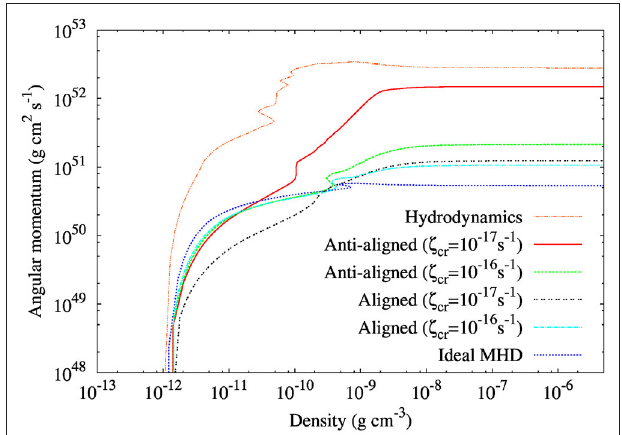
FIGURE 9 | The angular momentum in the first hydrostatic core which collapses to form a disc for models with various cosmic ray ionization rates, ζ cr . Only the purely hydrodynamics and the anti-aligned ( ζ cr = 10 − 17 s − 1 ) models form discs, both of which become bar-unstable. The angular momentum of the ideal MHD model differs slightly from that shown in Figure 6 due to different initial conditions. This is adapted from Figure 2 of Wurster et al. (2018c) , and was created for this publication using the data from Wurster et al. (2018c) .